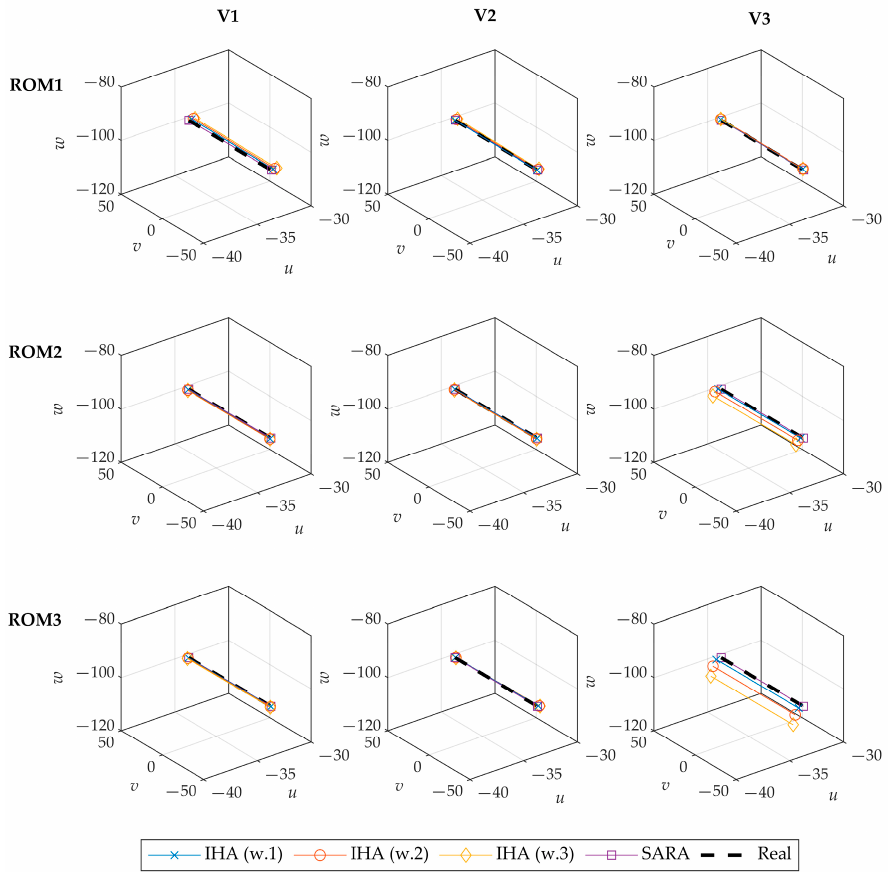
Figure 5. AoRs calculated with MHA, by choosing different weighting factors, and SARA, for motion configuration A. Each row and column correspond to a particular range of motion (ROM) and speed (V) selected, using the same nomenclature detailed in Section 2.3.2. The exact AoR imposed by joint kinematics setup is highlighted in dashed black line. All axes units are in mm.